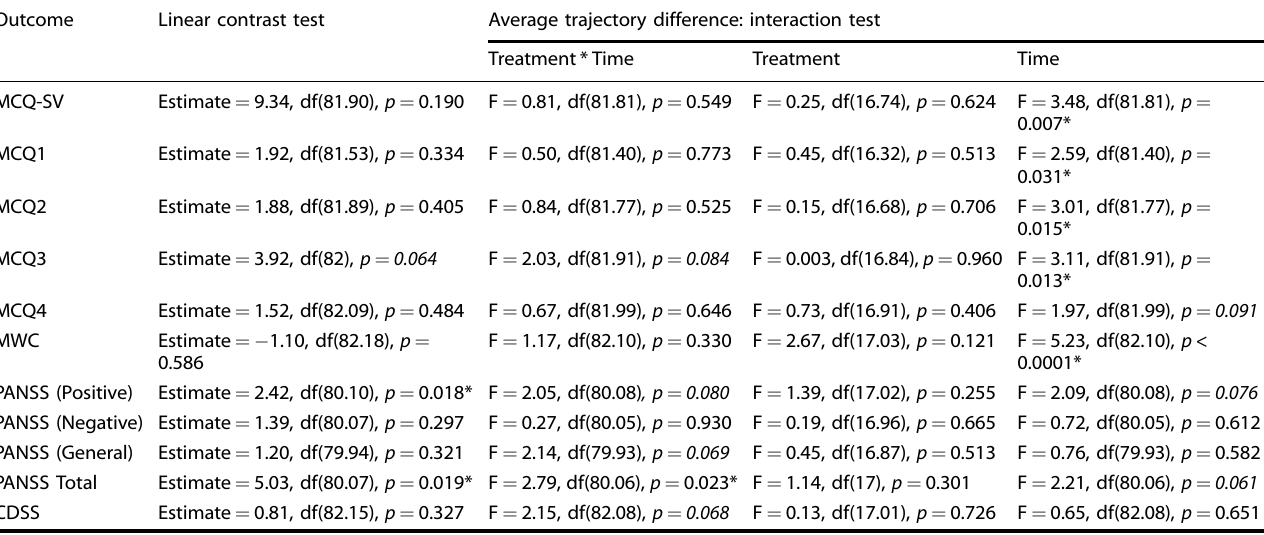
Table 4. Changes in cannabis craving, withdrawal and psychiatric symptoms from baseline to Day 28 in active compared to sham